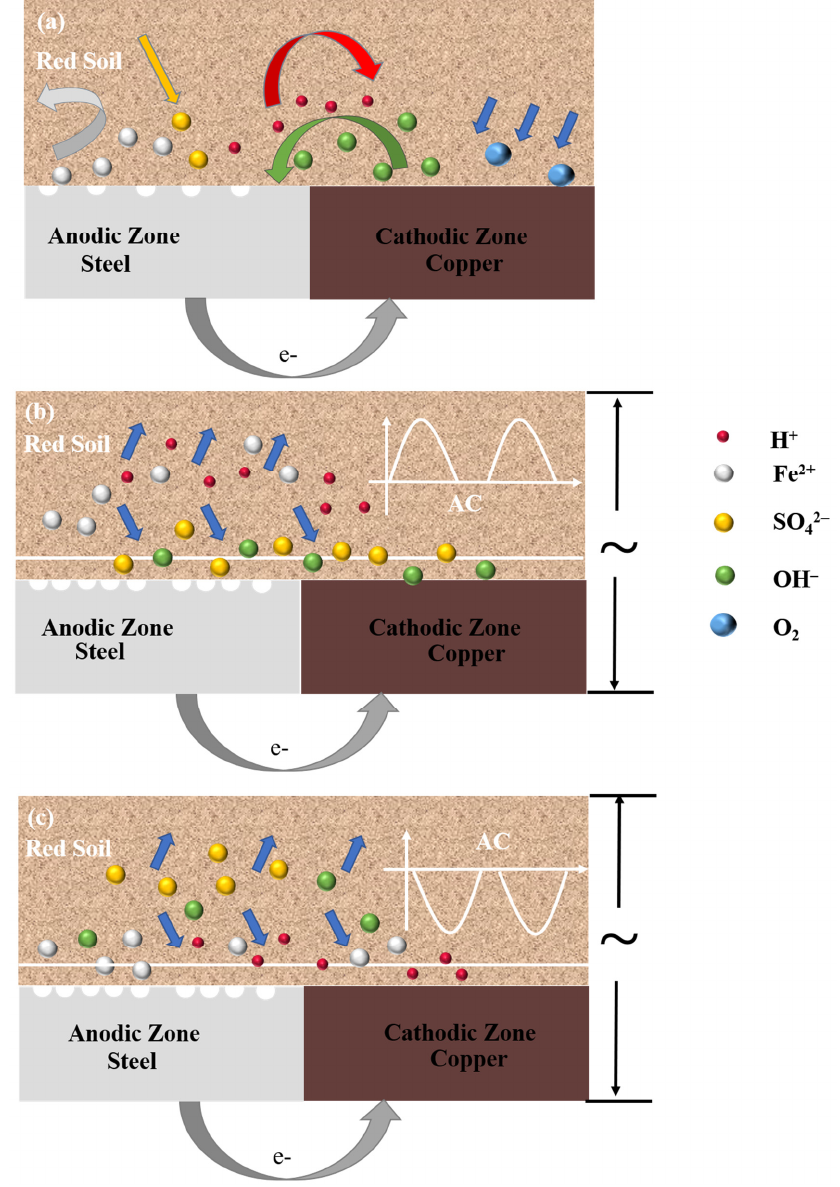
Figure 14. Schematic of corrosion processes and mechanism: ( a ) the galvanic couple without AC; ( b ) the galvanic couple with the positive branch of AC; ( c ) the galvanic couple with the negative branch of AC. Arrows represent migration direction of particles.